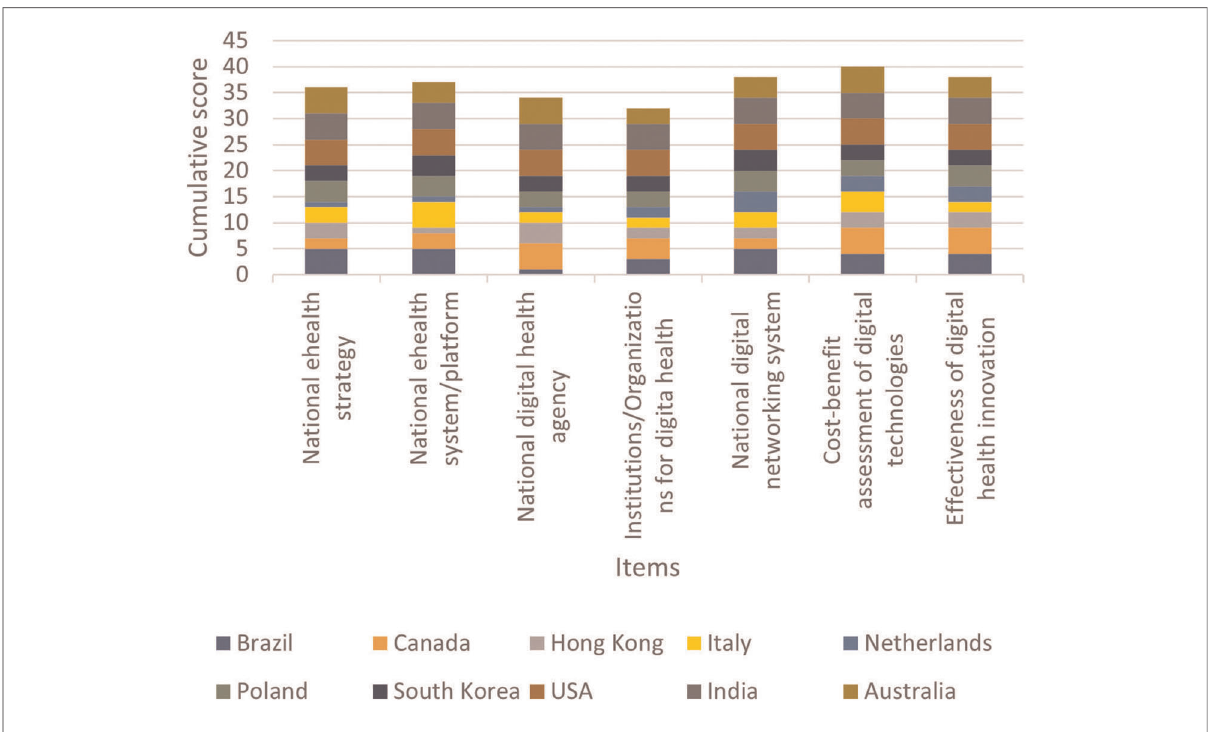
FIGURE 3 Cumulative score per proposed item of Topic